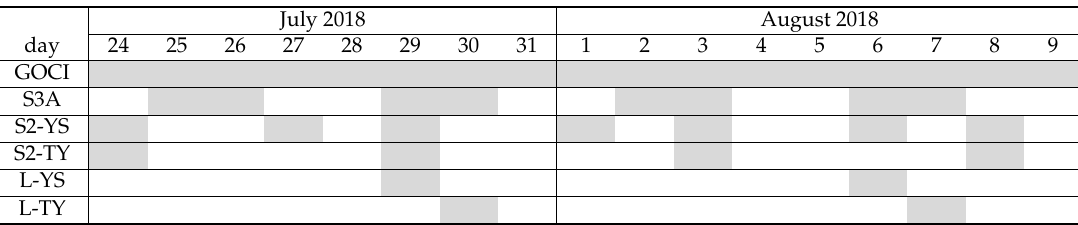
Table 3. List of available satellite images of the South Sea of Korea (SSK) during the red tide bloom event in